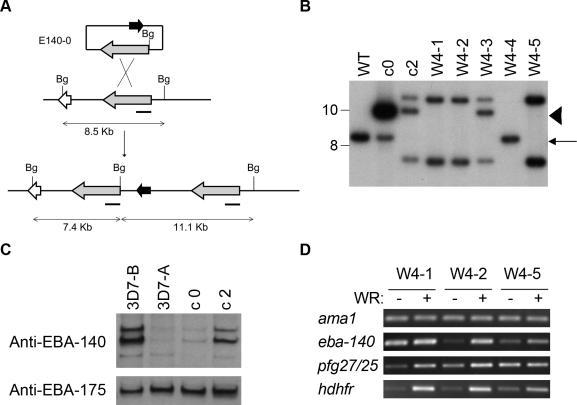
Activation of eba-140 by Insertion of a Drug Resistance Marker in Its Vicinity(A) Integration of the construct E140–0 (see Figure 5B) into the genomic eba-140 locus. The eba-140 and hdhfr genes are indicated by grey and black block arrows, respectively. The positions of the BglII sites (Bg) and the probe (line underneath the gene) used for the Southern blot analysis are indicated.(B) Southern blot analysis of E140–0 transfected 3D7-A parasites. The lanes correspond to BglII-digested genomic DNA from wild-type 3D7-A (lane WT), 3D7-A transfected with E140–0 before (lane c0) or after two cycles on/off drug (lane c2), and five subclones of the latter (lanes W4–1 to W4–5). The arrow indicates the position of the band for the wild-type gene and the arrowhead the position of the episome (identical to the position of a band obtained by integration of multiple copies of the construct).(C) Western blot analysis (as in Figure 2A) of schizonts extracts of 3D7-A, 3D7-B, and E140–0-transfected 3D7-A parasites before (lane c0) and after two cycles on/off drug (lane c2).(D) RT-PCR analysis of schizonts from subclones that had been maintained for 1 mo either in the absence (lanes −) or the presence (lanes +) of WR99210 drug (increasing concentrations from 10 to 40 nM). The single-copy gene ama1 was used to control the amount of stage-specific cDNA.